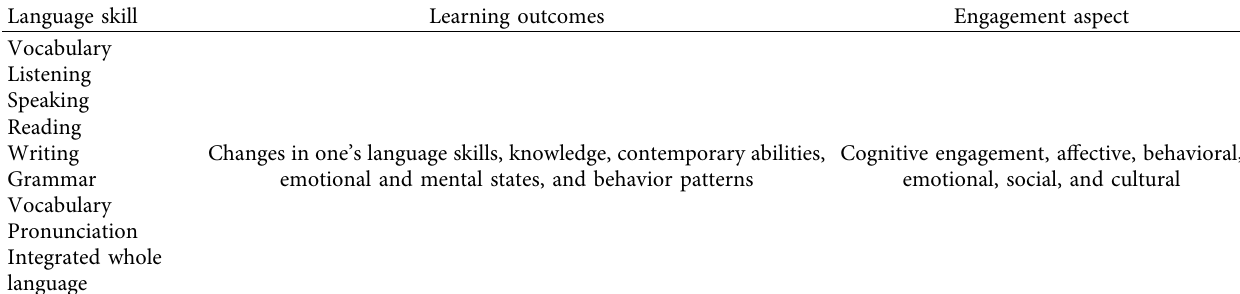
Table 1: Role of AI in language learning (adopted from Bailin [51] and Liang et al. [52]). Language